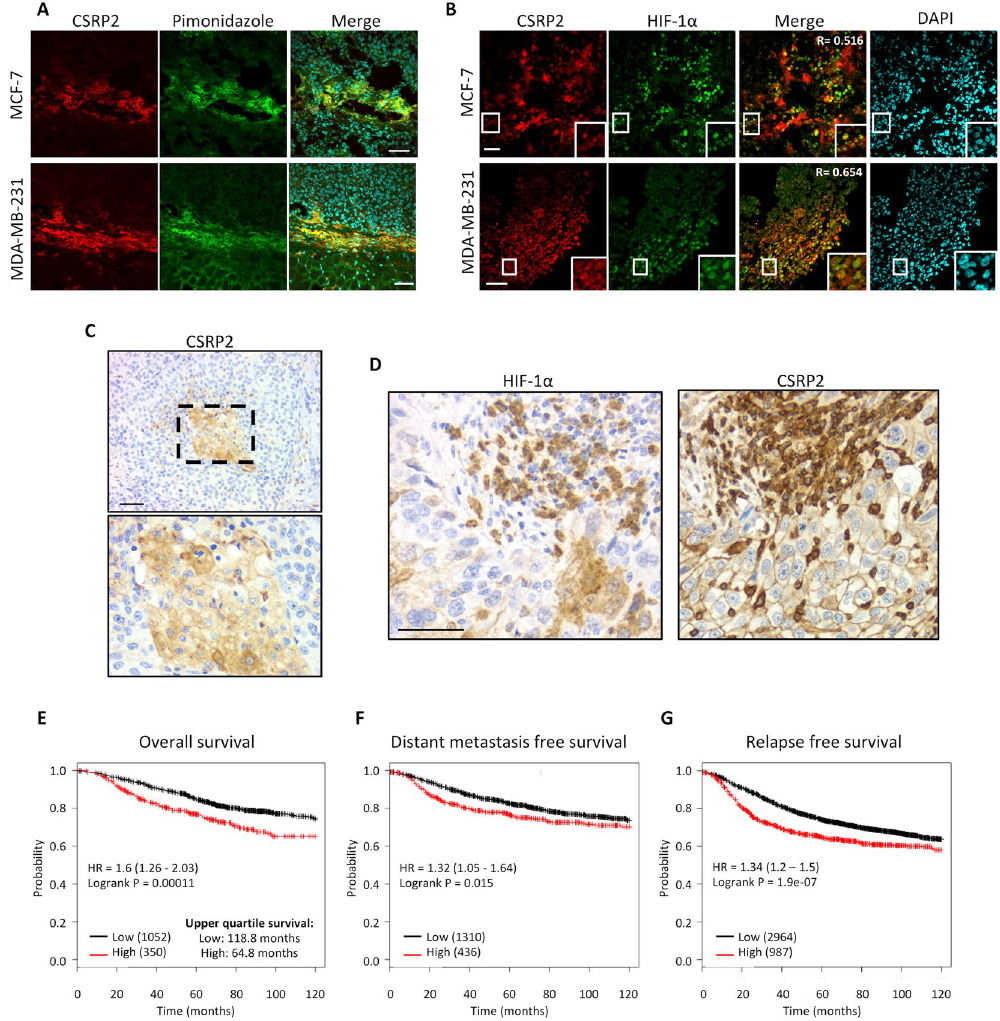
Figure 5. CSRP2 co-localizes with HIF-1 α in tumour xenografts and human breast cancer sections, and is significantly associated with worse outcomes in breast cancer patients. ( A , B ) MCF-7 or MDA-MB-231 murine tumour xenografts were sectioned, stained with pimonidazole and immunolabelled for CSRP2 and/or HIF-1 α . A correlation coefficient for co-localization of CSRP2 and HIF-1 α is indicated in ( B ). These results are representative of at least 21 tumour sections originating from 4 animals for each type of xenograft (Fig. S5). ( C ) Immunohistochemistry showing typical CSRP2 upregulation at the centre of a tumour nest (box) in a lymph node of metastatic breast cancer. ( D ) Representative example of serial tissue sections of a triple negative breast tumour stained for HIF-1 α and CSRP2 using immunohistochemistry. From the 48-sample TMA, a correlation coefficient value of 0.42 was calculated by Spearman Rank analysis (p = 0.0027; Table S1). ( E – G ) Kaplan-Meier survival analyses in relation to CSRP2 expression (affy ID 207030s_at) in breast carcinoma using overall ( E ) distant metastasis free ( F ) or relapse free ( G ) survival as an endpoint. The patient samples, hazard ratio with 95% confidence interval, and p value (Logrank test) are displayed on each chart. Upper quartile survival for patients with low and high CSRP2 expression is indicated in ( F ). Bars = 50 µ